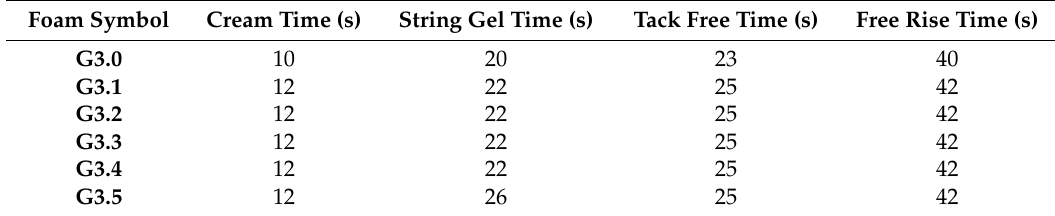
Table 4. Processing time of RPU/PIR foams with